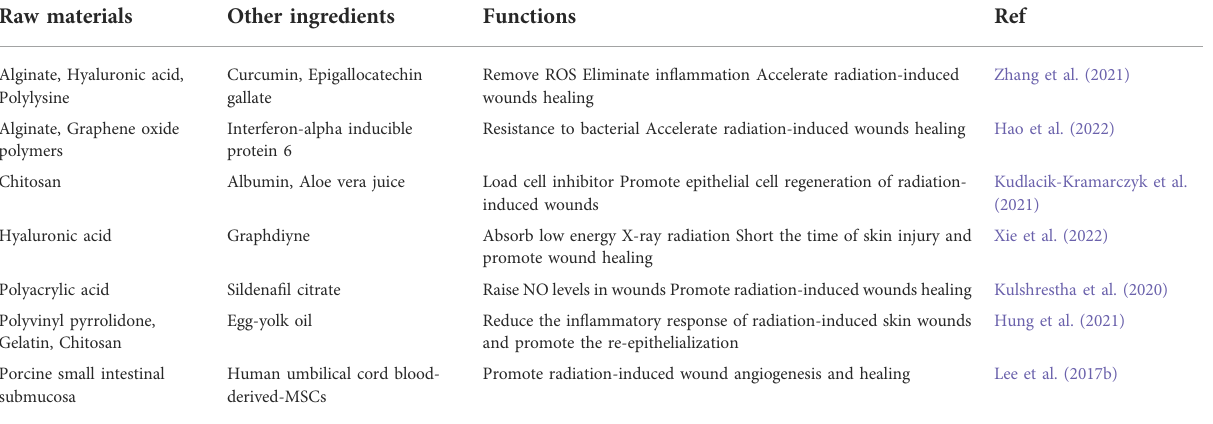
TABLE 2 Materials and functions of hydrogels which were highlighted in this